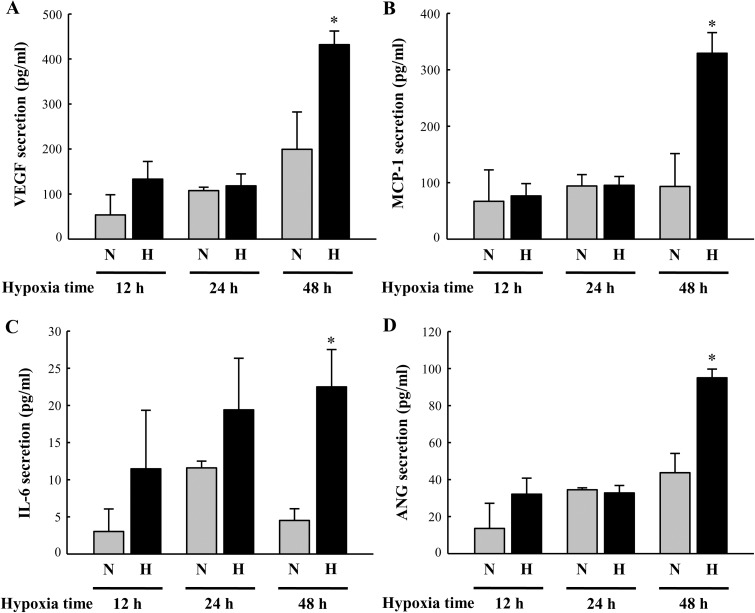
BM-MSC-conditioned media contains paracrine factors when cells are exposed to hypoxia.Paracrine factors were measured in the hypoxia-exposed BM-MSC-conditioned media by Magnetic Luminex assay. VEGF (A), MCP-1 (B), IL-6 (C), and ANG (D) expression in response to hypoxia exposure time in comparison with normoxia. N or H indicate normoxia or hypoxia, respectively. All data are expressed as mean ± SD (n = 5 per group). *P < 0.05 vs. normoxia for 48 h.